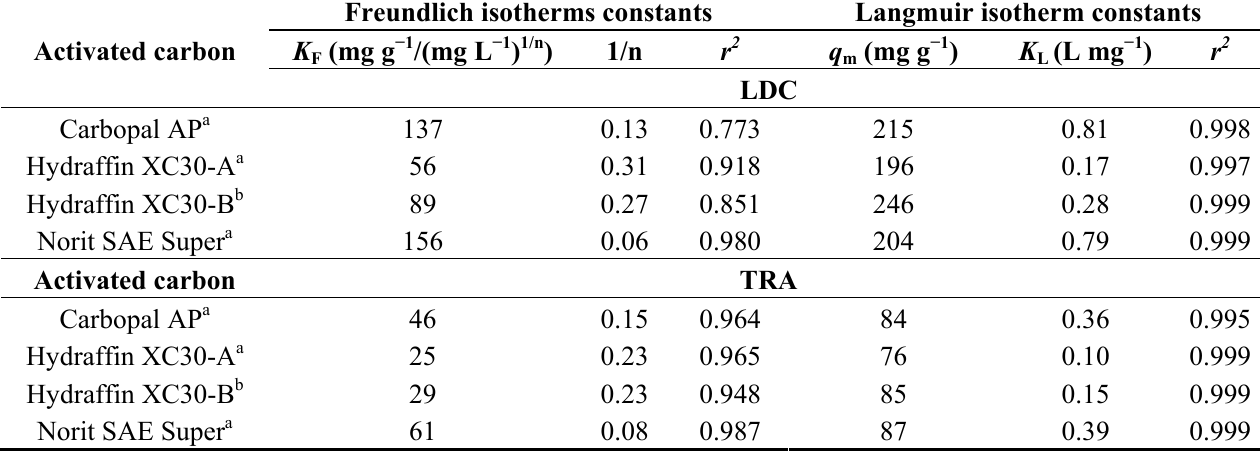
Table 4. Fitting parameters to the Langmuir and Freundlich models of the equilibrium adsorption isotherms (at 25 °C) of lidocaine (LDC) and tramadol (TRA) onto the activated carbons used in this